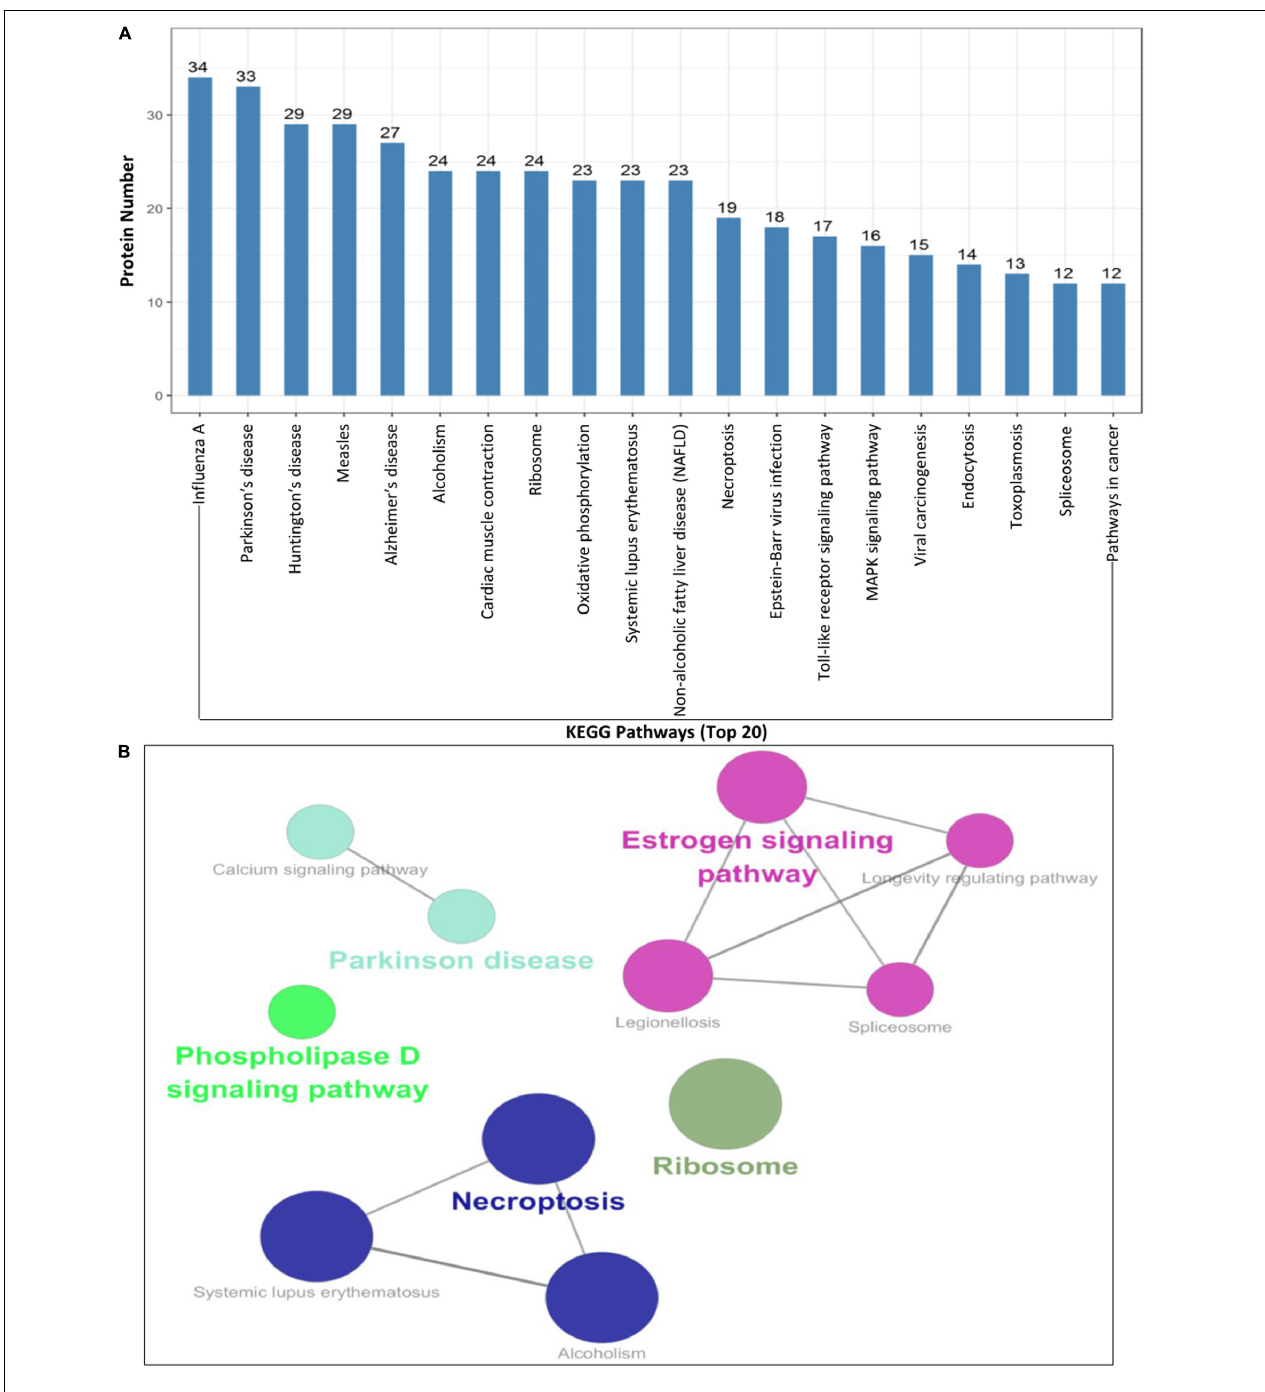
FIGURE 4 | KEGG pathway enrichment analysis. (A,B) Graph shows the enriched pathways targeted by PCV2 Cap-interacting proteins, analyzed by KEGG functional annotation pathway database ( Supplementary Tables S4, S5 ) using software Cytoscape 3.7.1 with plugin GOclue ( Supplementary Figures S1A,B ). Schematic representation of the MAPK signaling pathway (imported from KEGG: map04010) and the spliceosome pathway targeted by PCV2 Cap-interacting proteins (imported from KEGG: map03040). Proteins interacting with PCV2 Cap within the entire pathway are depicted red color.